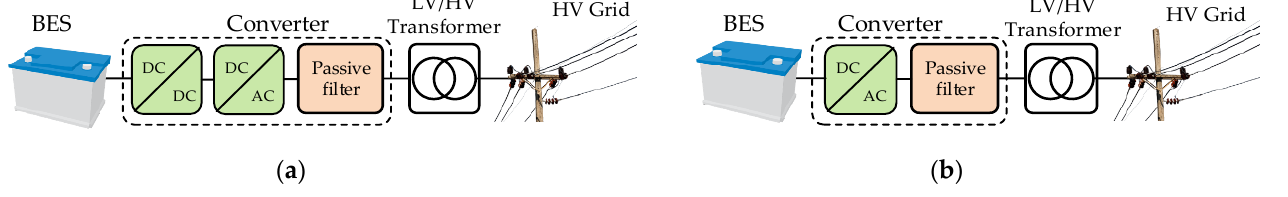
Figure 5. BESS power electronics converters with a transformer: ( a ) single-stage, ( b ) two-stage.